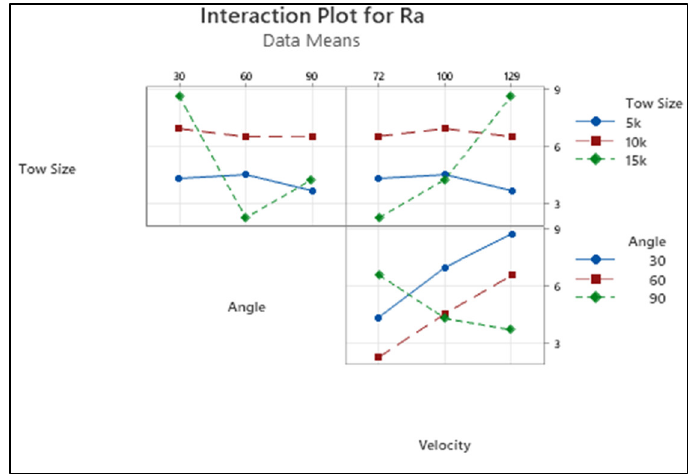
Figure 5. Interaction plot for R a .